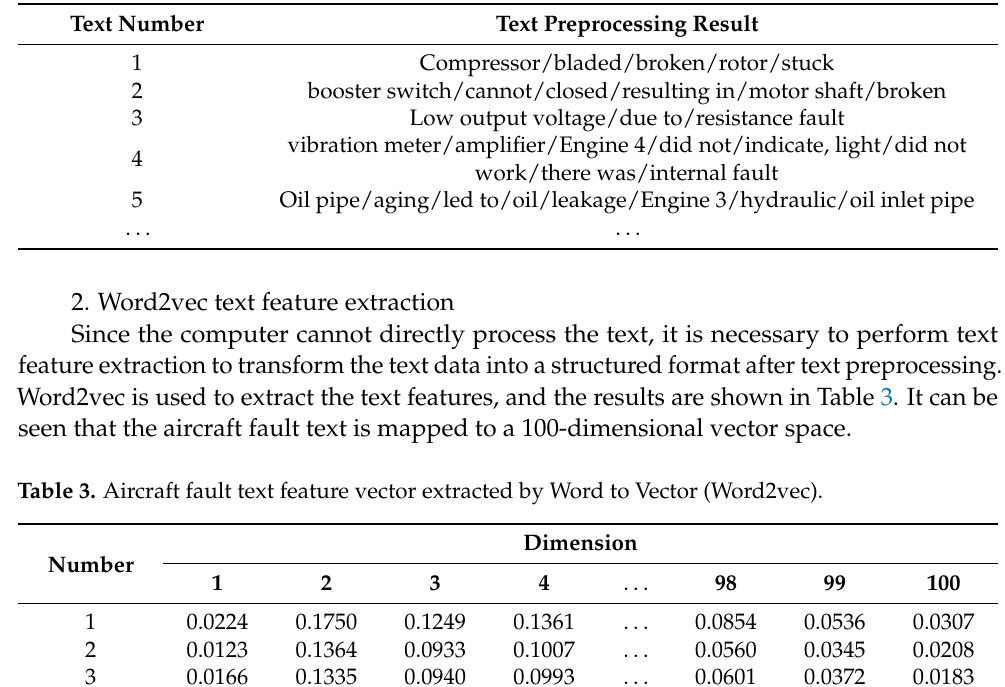
Table 2. Examples of aircraft fault text after preprocessing.